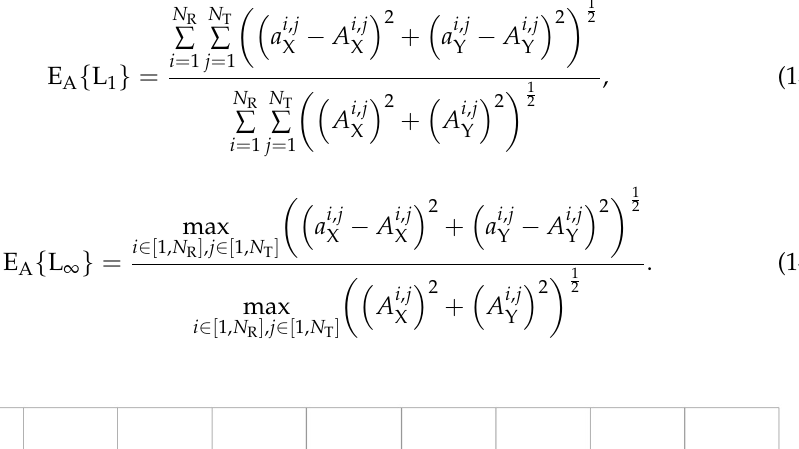
Figure 7. Dependence of the relative errors of the anomalous velocity on the angle α.